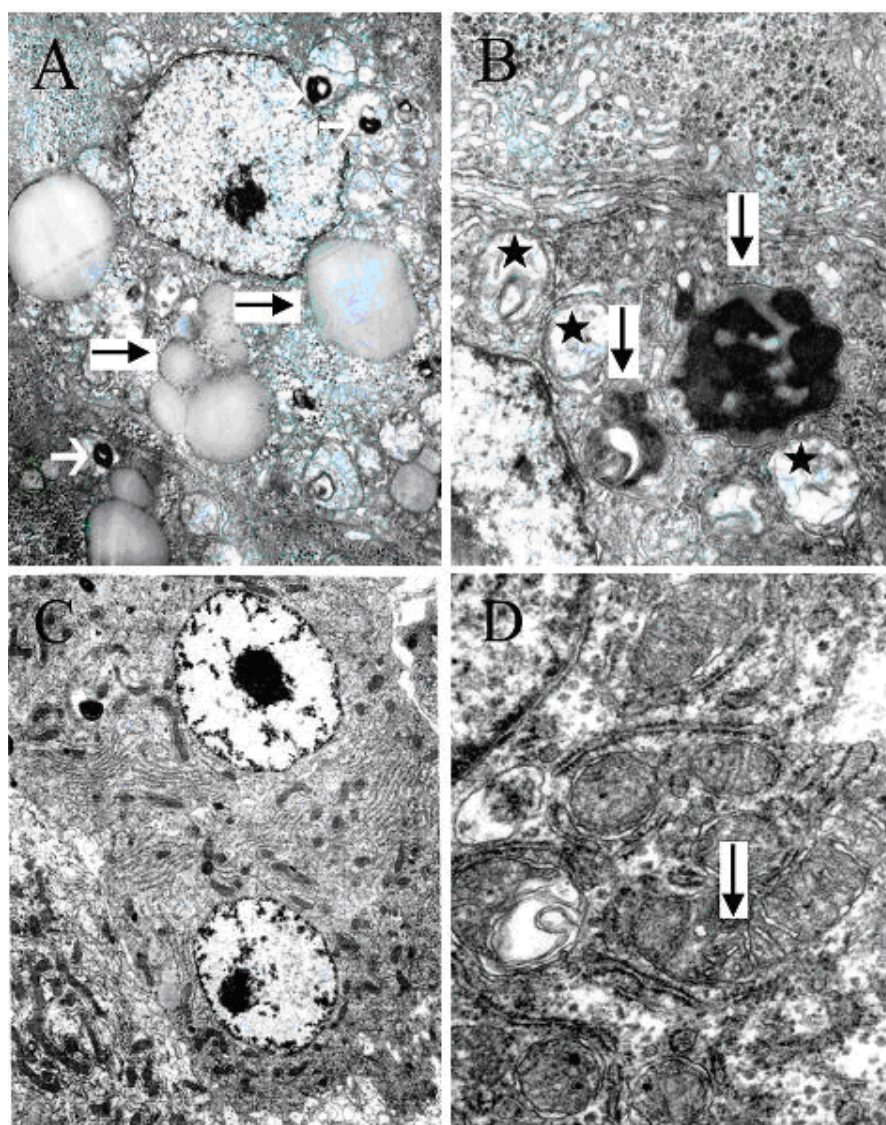
FIGURE 4. Transmission electron micrograph of the liver of bighead carp collected from the fish pen in Meiliang Bay of Taihu Lake during July (A and B) and December (C and D), 2004. (A) The increase of lipid droplets in size and number (black arrows) and the presence of vacuoles with myelin bodies (white arrows), 8000×; (B) augmentation of the amount of secondary lysosomes (black arrows) and some vacuoles (asterisks), 15000×; (C) the intact hepatocytes with abundant mitochondria and stacks of endoplasmic reticulum, 6000×; (D) normal mitochondria with clear cristae (black arrows),